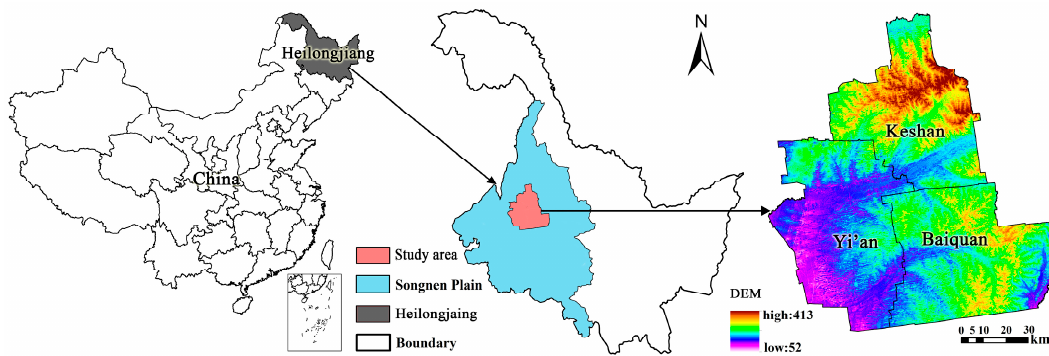
Figure 1. Location of the study area.